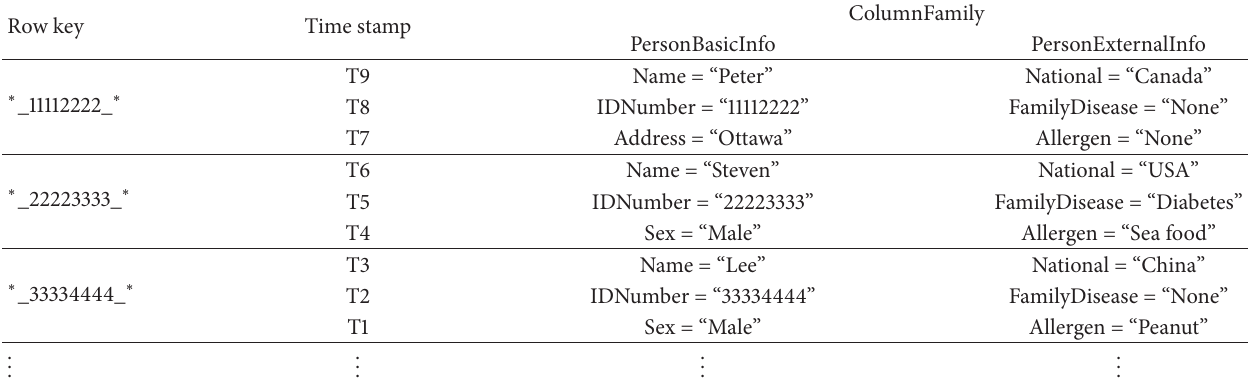
Table 1: Design of table in